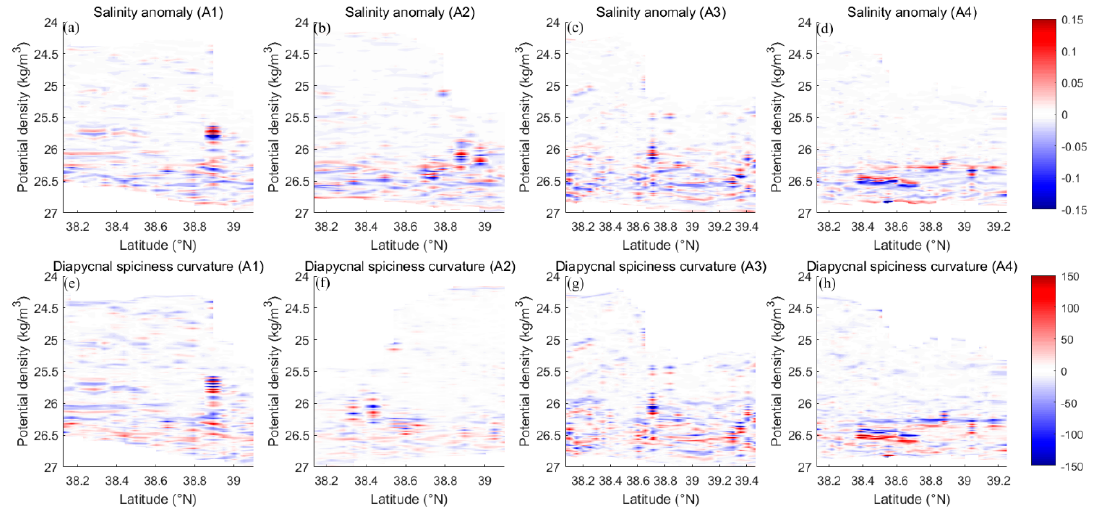
Figure 5. ( a – d ) Salinity anomaly (shading in psu) and ( e – h ) diapycnal spiciness curvature (shading in m 3 /kg) of the four sections.